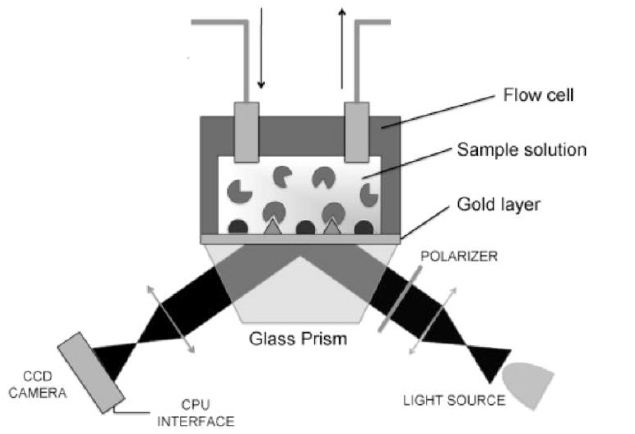
Figure 5. Surface plasmon resonance imaging (SPRi) setup: Instead of measuring at one spot like with the SPR, the reflection of a number of spots is measured using a CCD camera. Reproduced from [68] with permission from